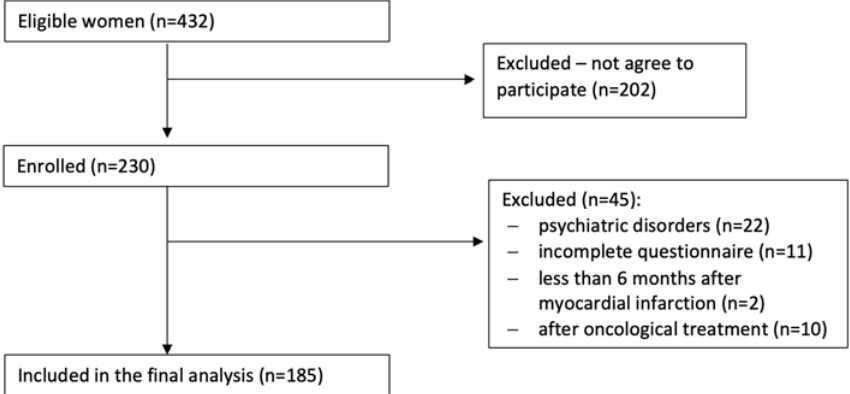
Figure 1. Study flow chart.